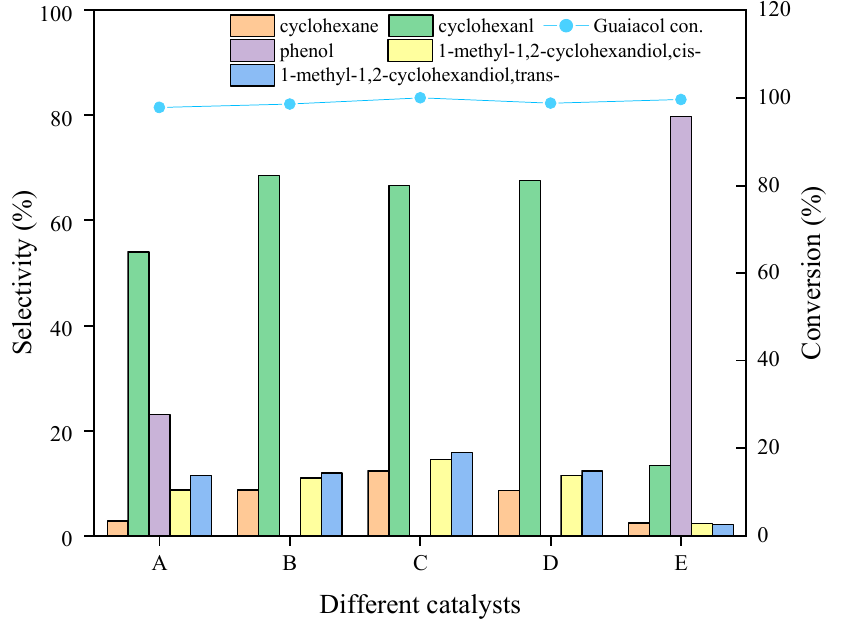
Figure 4. Guaiacol conversion and product distribution over different catalysts. Reaction conditions: T = 240 °C, p = 2 MPa, and t = 4 h; catalysts: (A) Ni@C, (B) Ni5Mo1@C, (C) Ni4Mo1@C, (D) Ni3Mo1@C, and (E) Ni2Mo1@C.